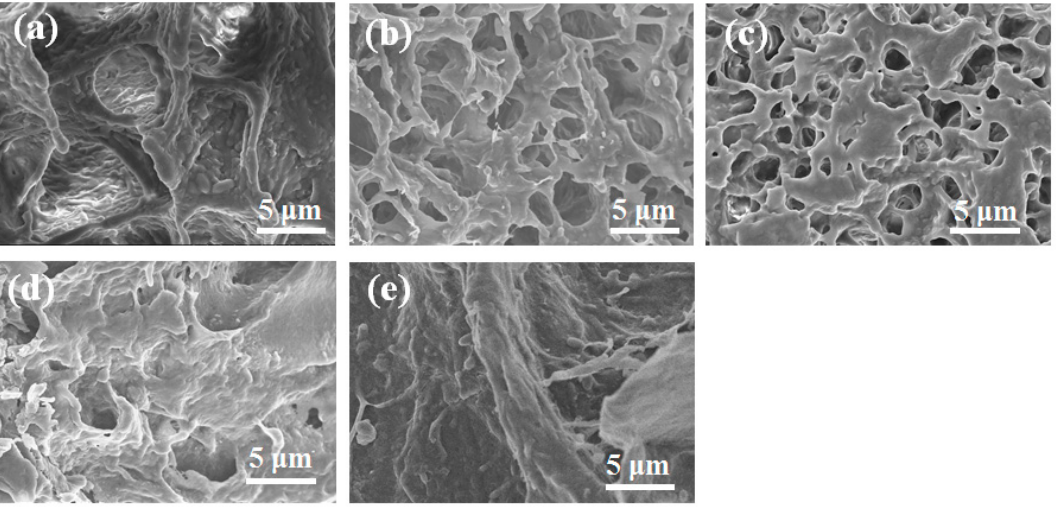
Figure 3. SEM images of CNC/Hydrogel with various contents of CNC. ( a ) 0%, ( b ) 5%, ( c ) 10%, ( d ) 15%, and ( e ) 20%.